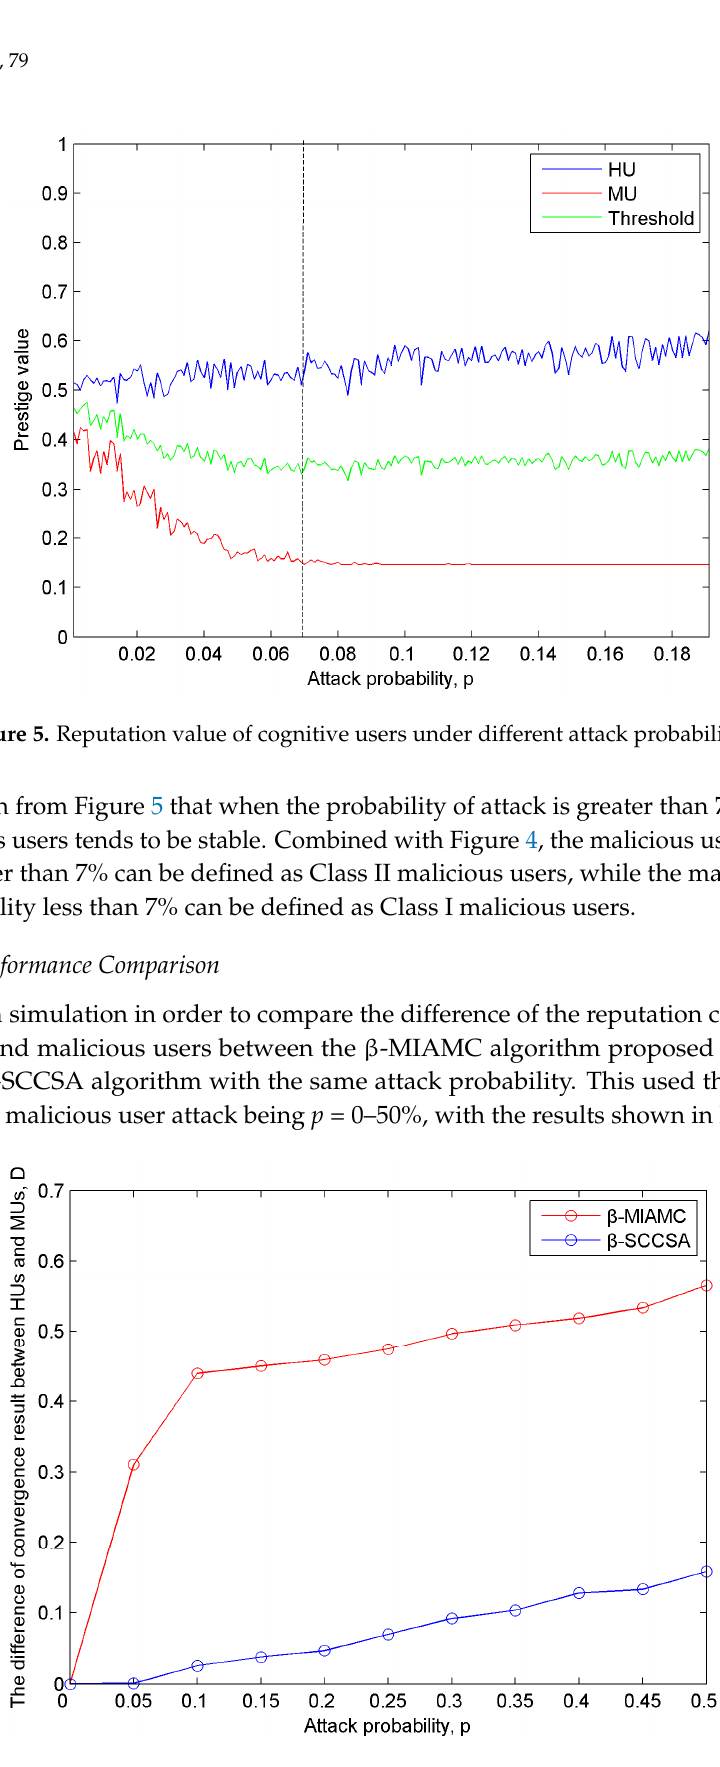
Figure 6. The difference between the honest user and the malicious user convergence results under different attack probabilities.